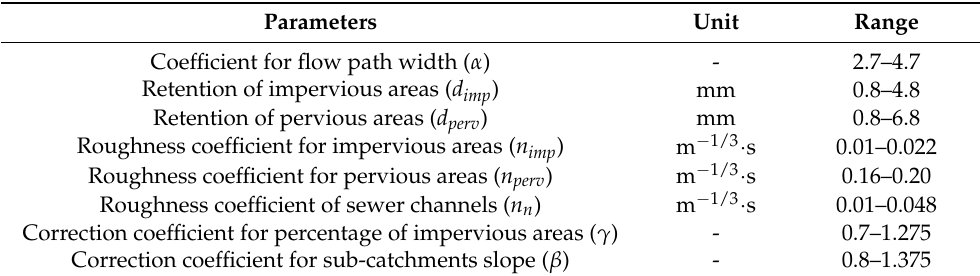
Table 1. Ranges of variability of model parameters for the a priori uniform distribution